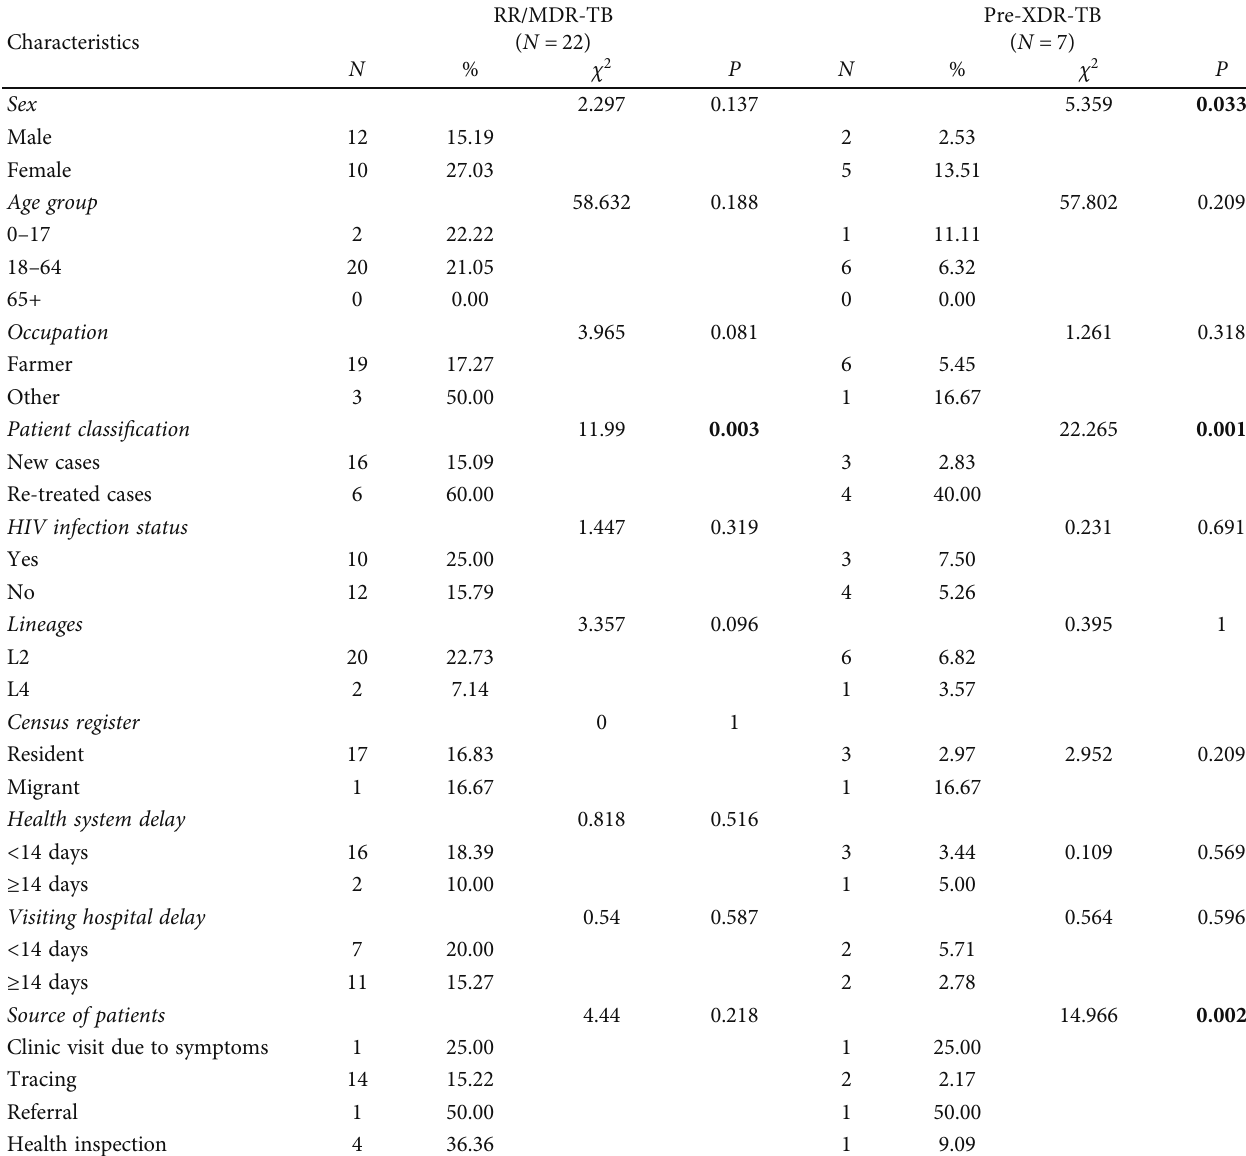
Table 3: Demographic, bacteriological, and clinical characteristics of drug-resistant tuberculosis cases in the Yi ethnic group, Sichuan,